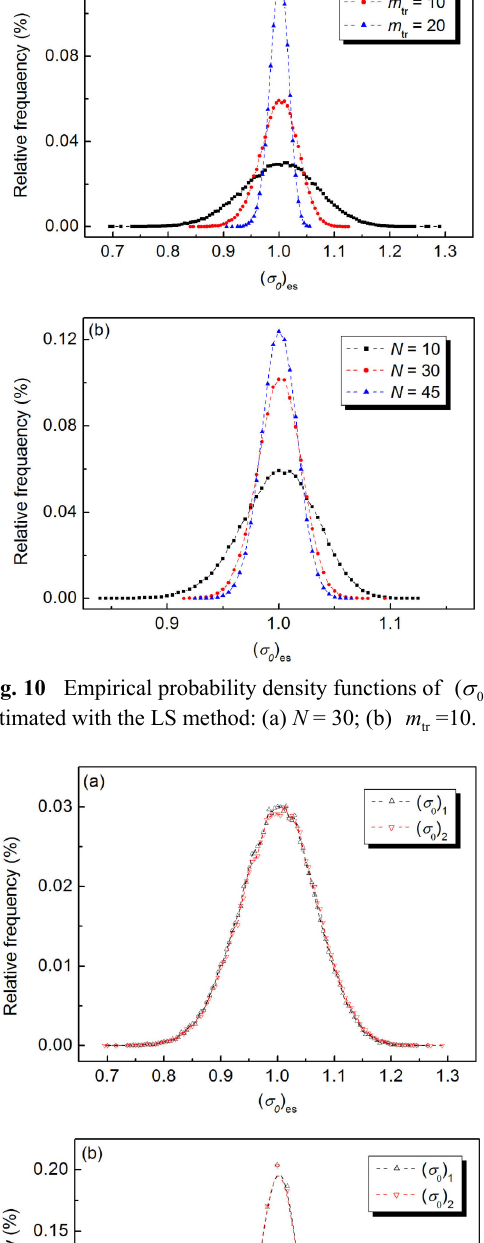
Fig. 11 Comparisons of the empirical probability density curves of ( )  and ( )  : (a) N = 10, 0 1 0 2 m = 20. tr